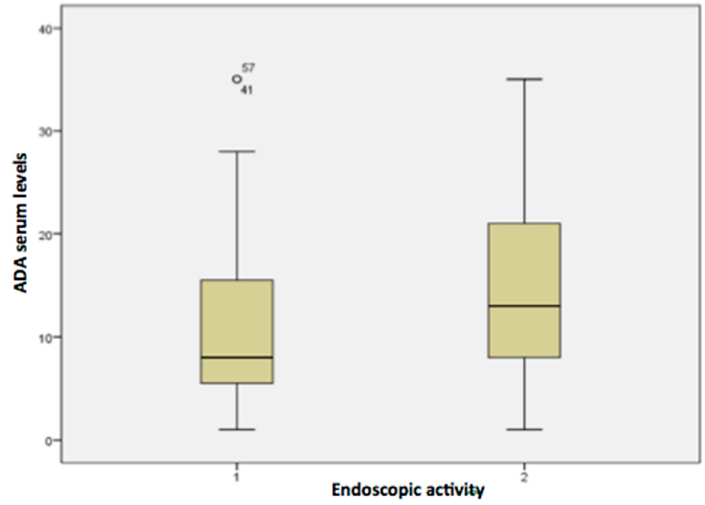
Figure 2. Boxplot demonstrating median serum ADA concentrations and endoscopic disease activity in cd (1: endoscopically active disease; 2: endoscopic remission). Table 3. Clinical and endoscopic disease activity according to different cut-off values of ADA serum